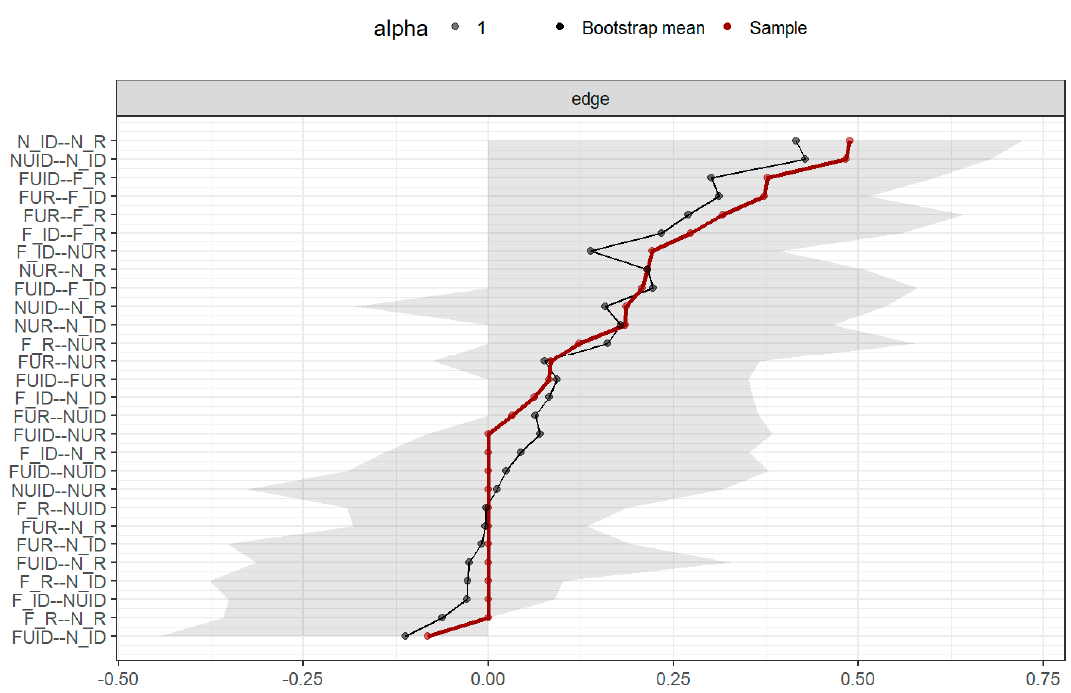
Figure 9. Centrality stability is investigated using subset bootstrapping for the Spanish subsample.